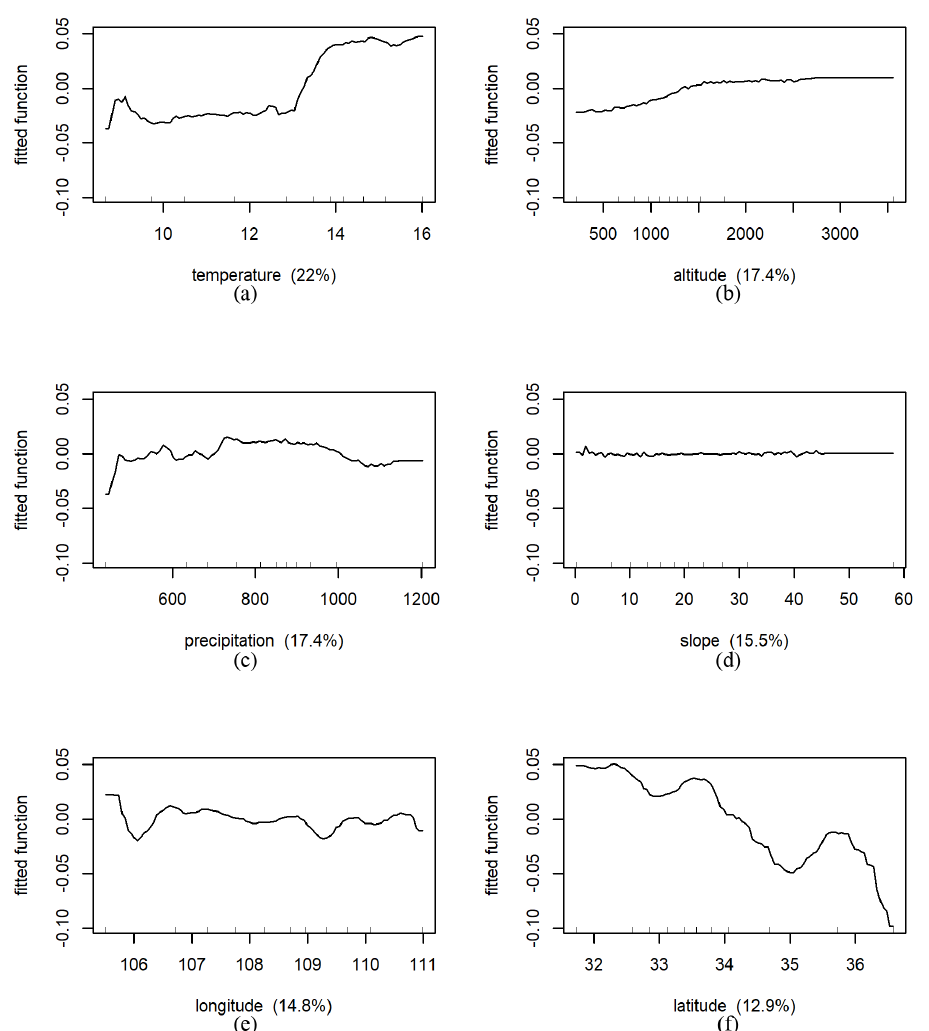
Figure 19. Results of marginal effects of environmental factors on NDVI under forest land type in whole Shaanxi Province (The fitted function of NDVI vs. ( a ): temperature (°C), ( b ): altitude (m), ( c ): precipitation (mm), ( d ): slope (°), ( e ): longitude (E), ( f ): latitude (N), respectively. The x -axis denotes the predictive variable; the contents in brackets in the title of the x -axis represent relative influence. The y -axis denotes the marginal effect of the selected variables by “integrating” out the other varia- bles).